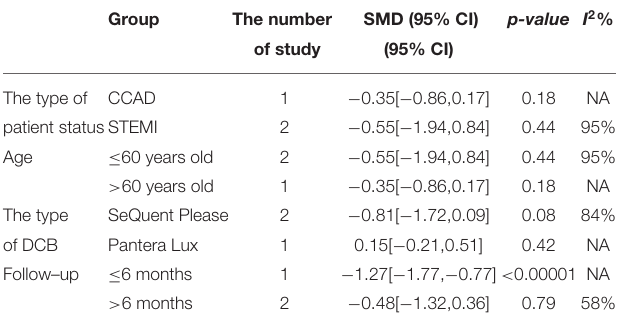
TABLE 4 | The subgroup analysis of LLL.